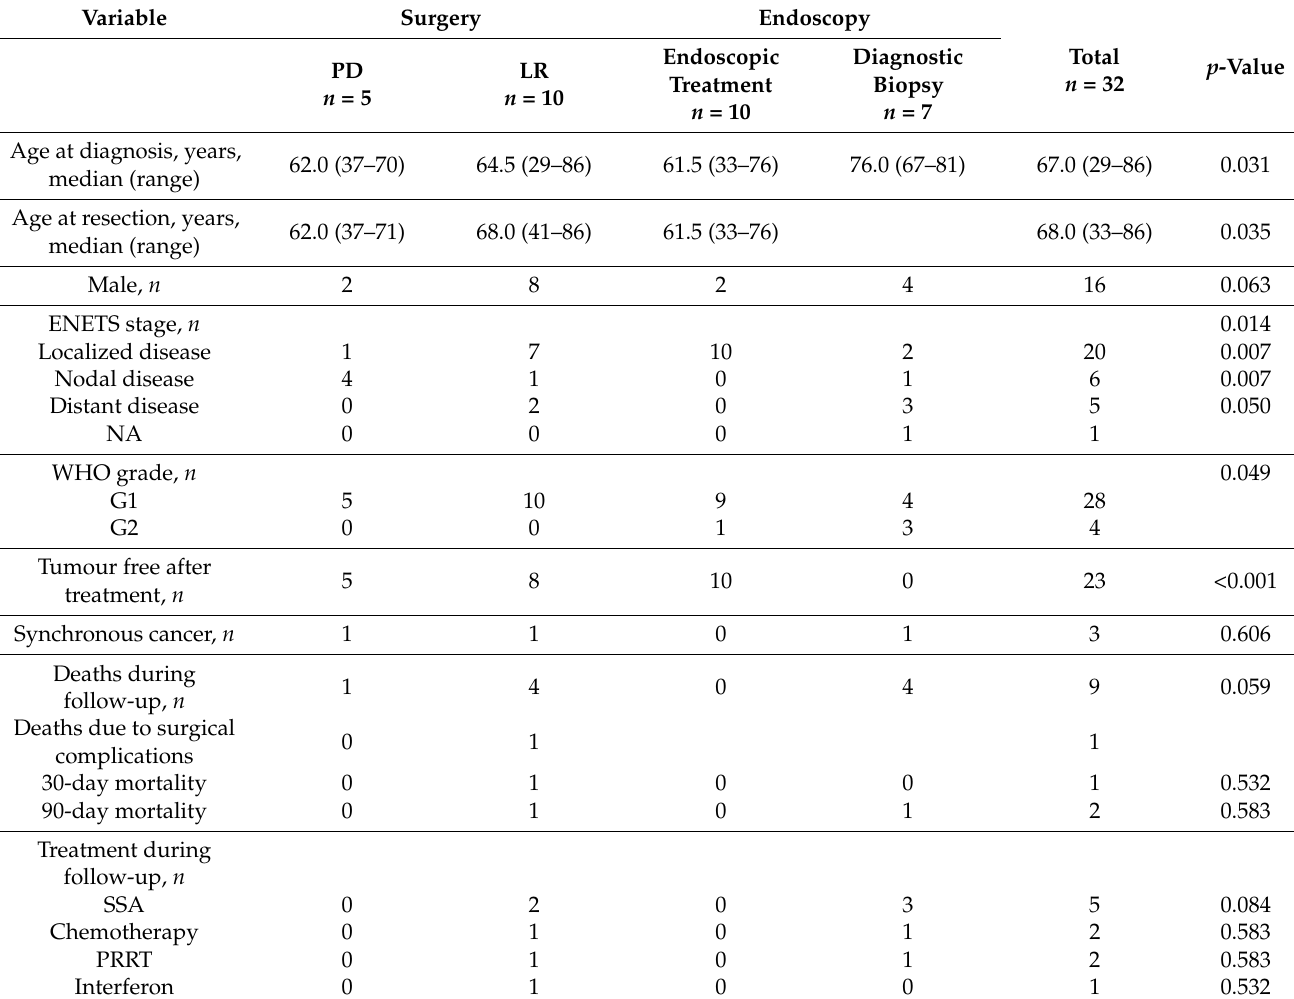
Table 1. Demographics, disease and intervention in patients with